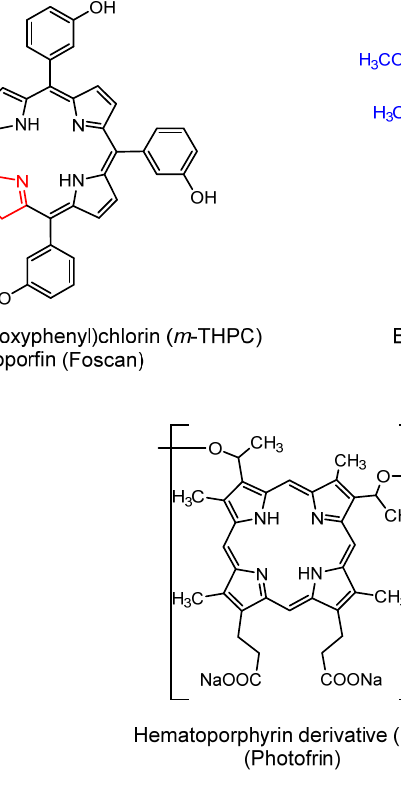
Figure 16. Molecular structures of photosensitizers approved for PDT treatment.